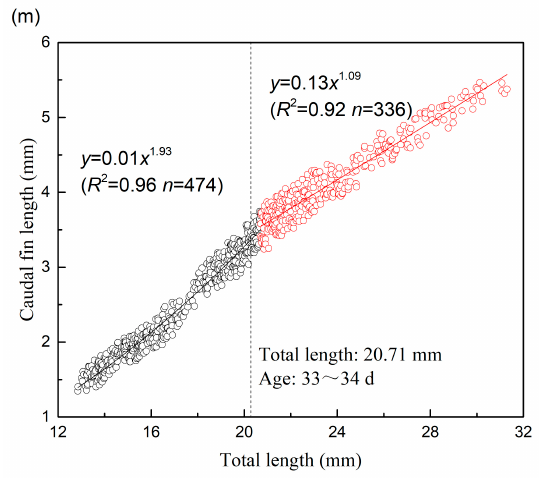
Figure 8. Allometric growth curve and equations of S. waltoni during larval and juvenile periods.